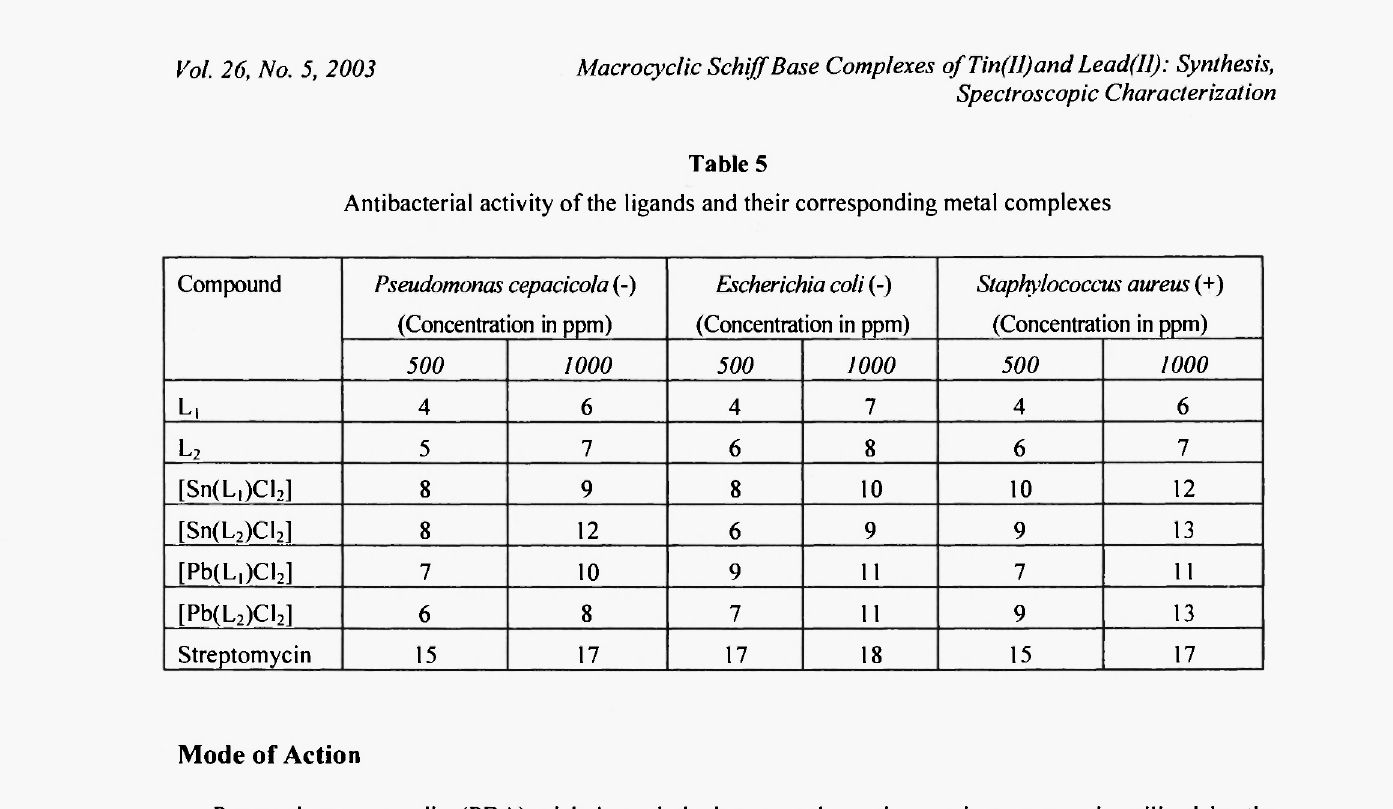
Antibacterial activity of the ligands and their corresponding metal complexes